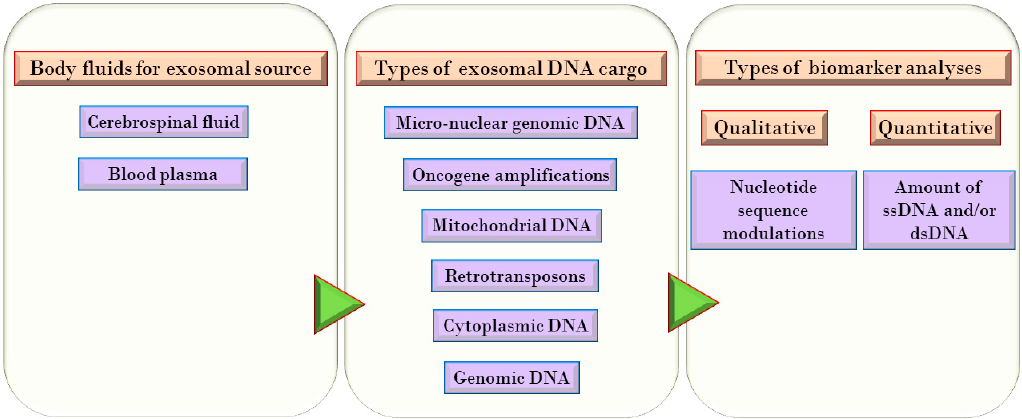
Figure 1. Exosomal DNA as brain cancer biomarkers. The selection of body fluids, the types of DNA and the analyses performed with the exosomal DNA to establish them as prognostic, diagnostic or therapy response biomarkers for the brain cancers.